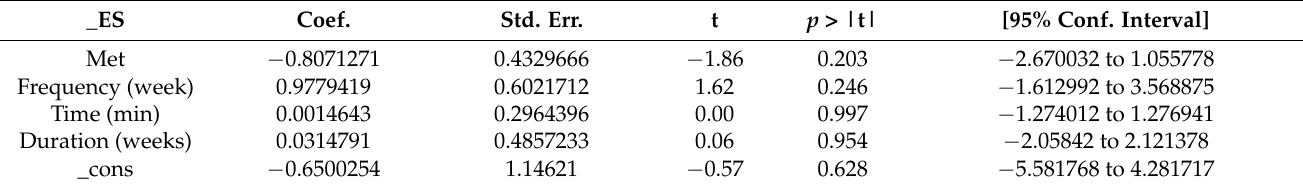
Table 5. Covariate Regression Analysis of Physical Activity on University Students’ Depression.